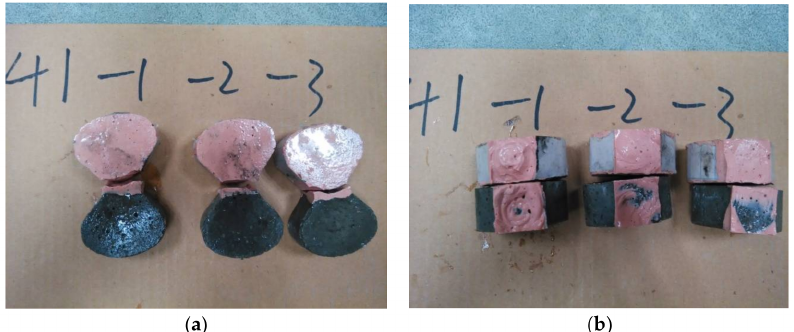
Figure 3. Test for adhesive strength of the geopolymer coating. ( a ) Samples for the test of adhesive strength; ( b ) Fractured